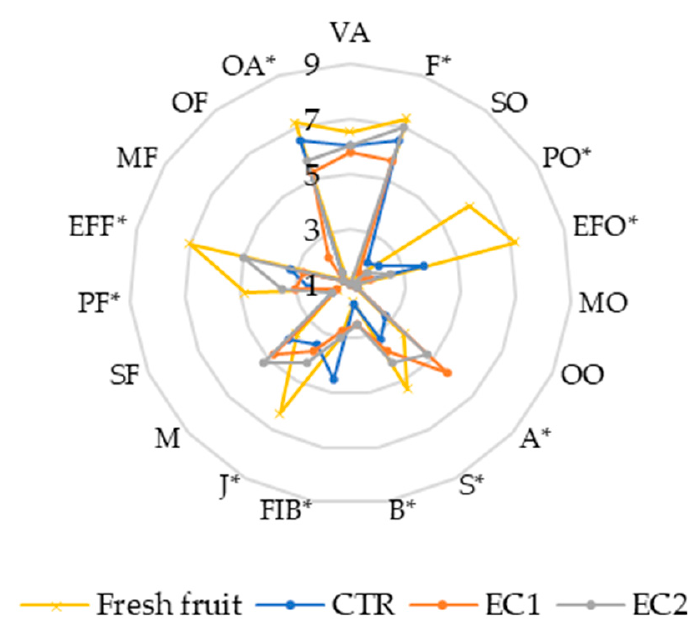
Figure 9. Sensory analyses of fresh-cut mango cubes after five days of cold storage. Descriptors: visual